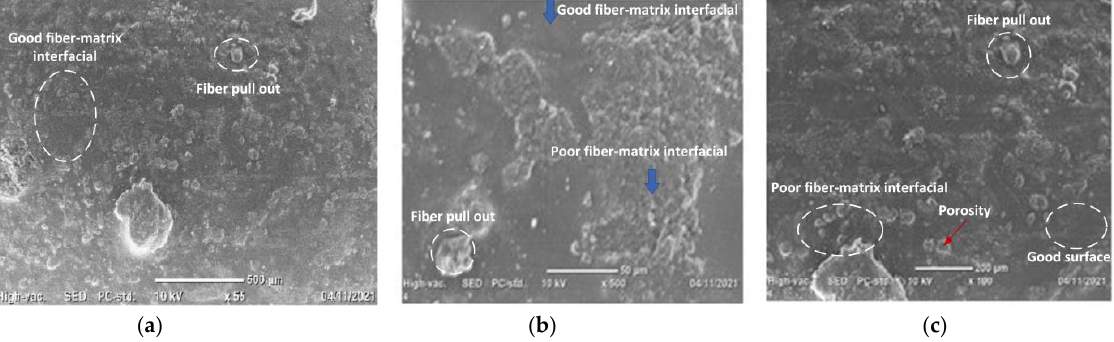
Figure 8. SEM image of woven enset/sisal hybrid composite ( a ) untreated; ( b ) 5% NaOH-treated; and ( c ) 10% NaOH-treated.